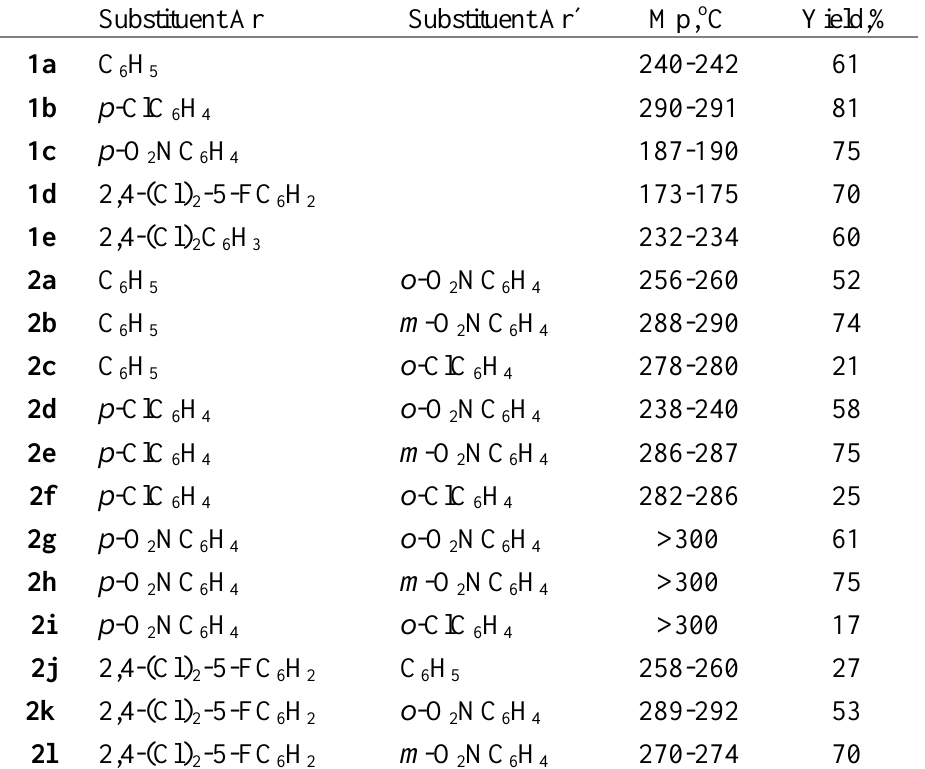
Table 1. Structure of compounds 1a-1e and 2a-2l , their melting points and yields of